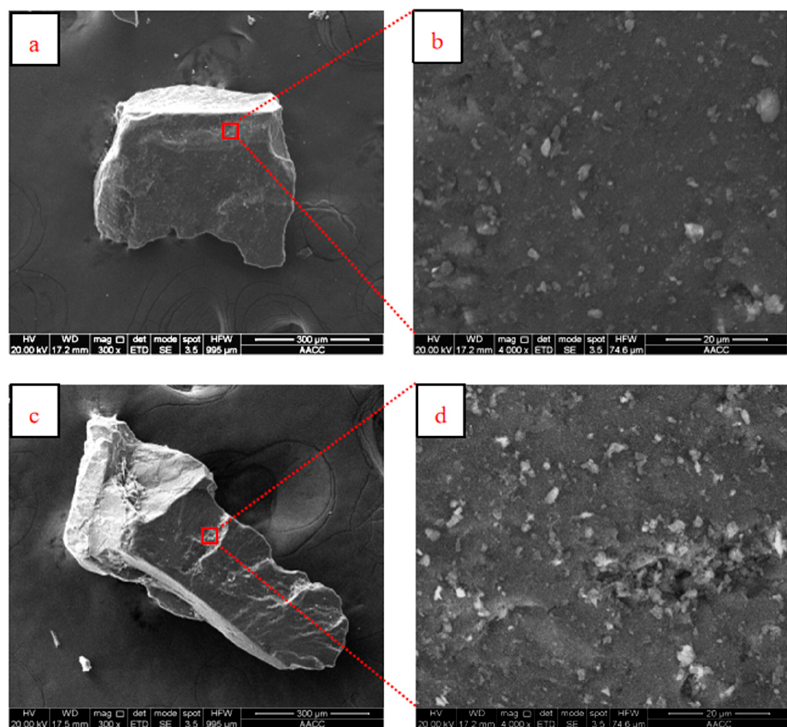
Figure 6. SEM images of different comminution products; ( a ) rod-milled products at 300× resolutions, ( b ) rod-milled products at 4000× resolutions, ( c ) crushed products at 300× resolutions, ( d ) crushed products at 4000× resolutions.